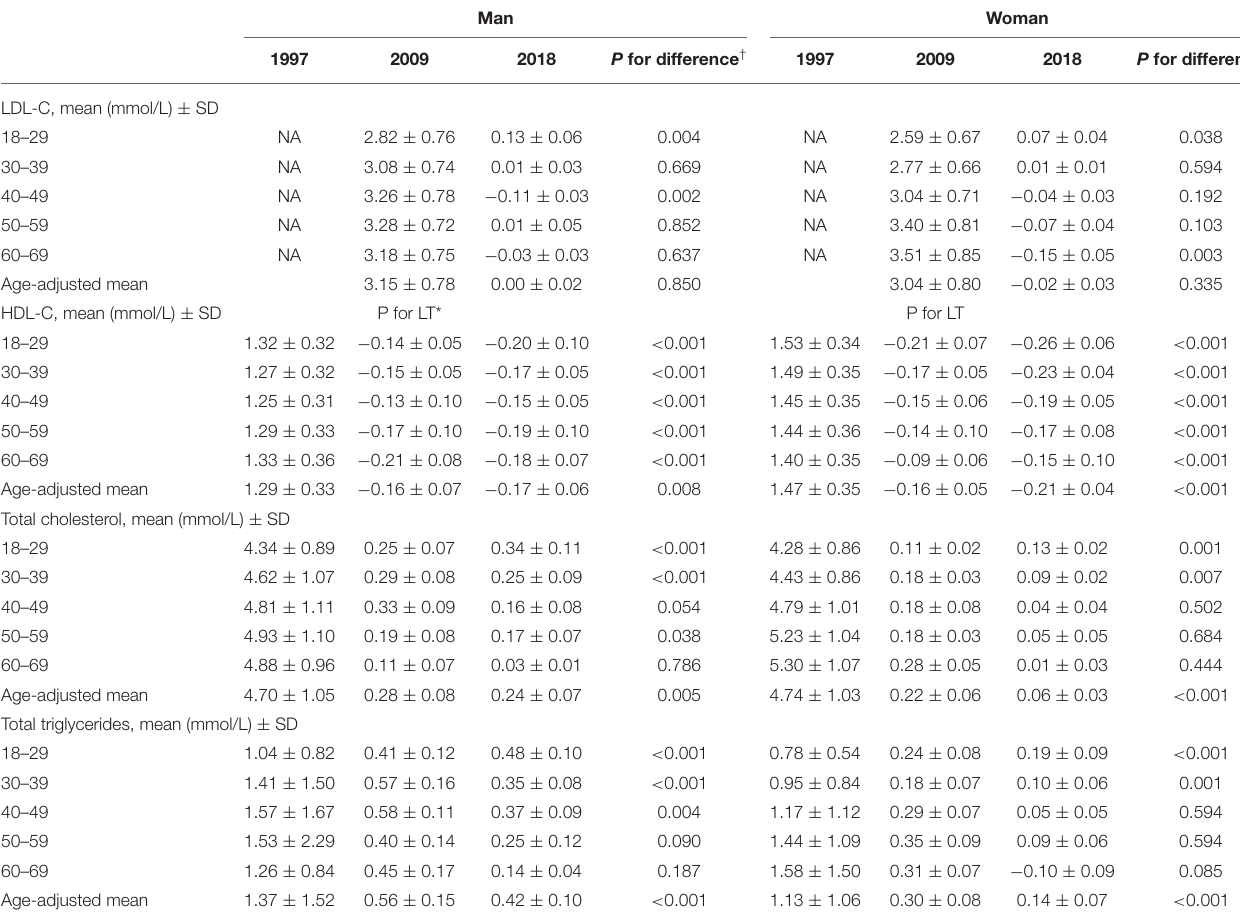
TABLE 2 | Age-adjusted lipid profiles from 1997 to 2018.